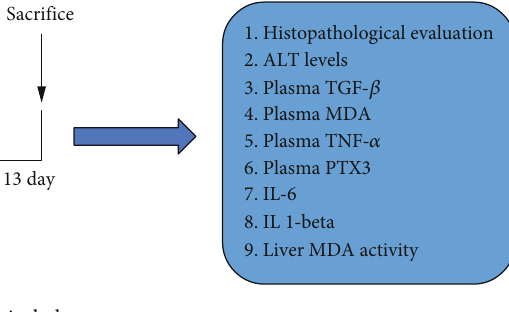
Figure 1: Graphical abstract.